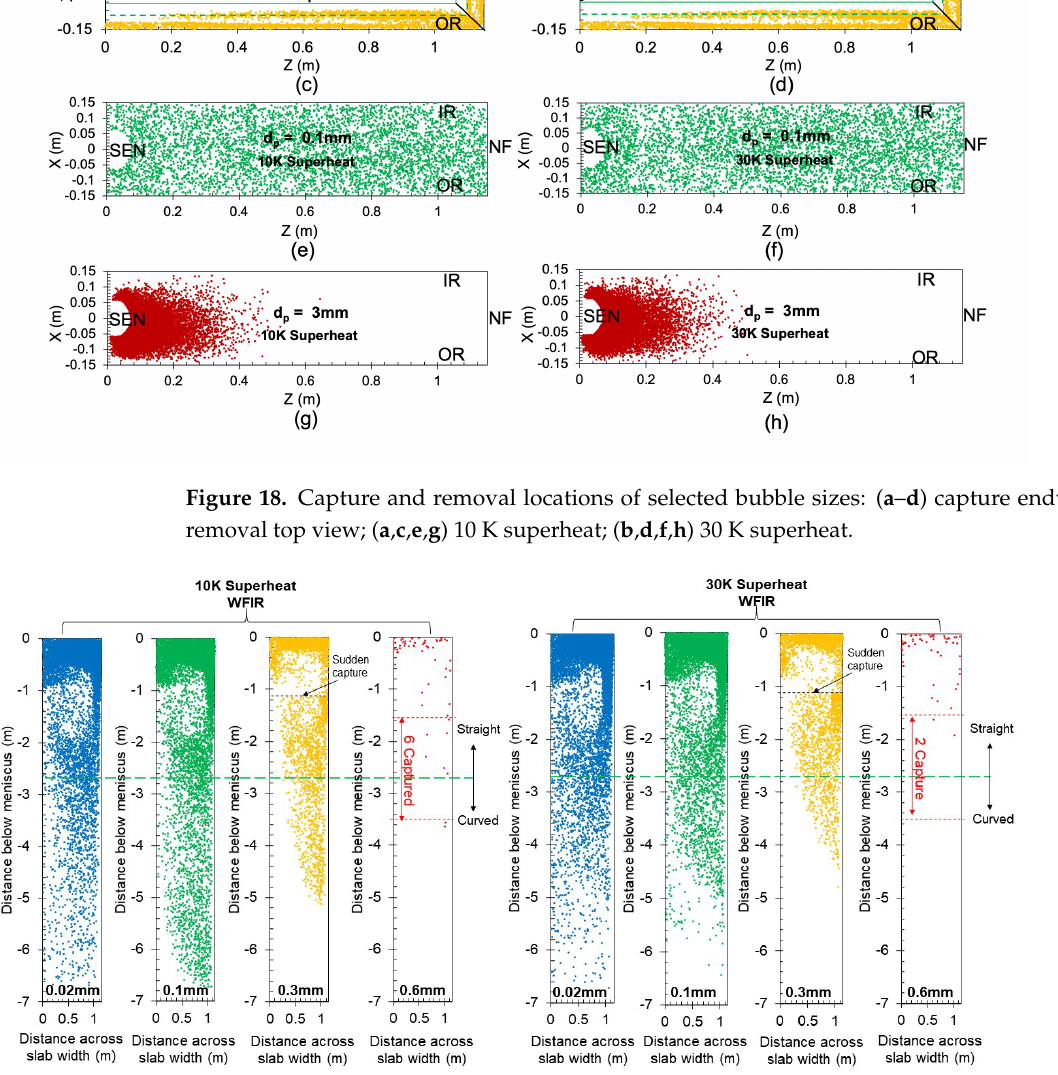
Figure 19. Capture locations on the wide face inner radius (WFIR) for selected bubble sizes—front